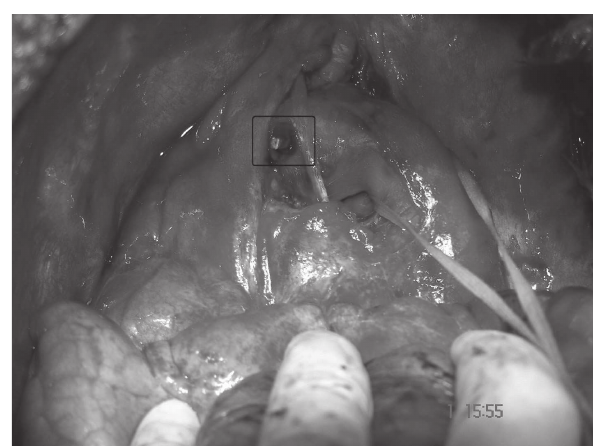
Fig. 2 - Foto intra-operatória com local de saída do fio de aço transfixando a artéria aorta torácica, na porção